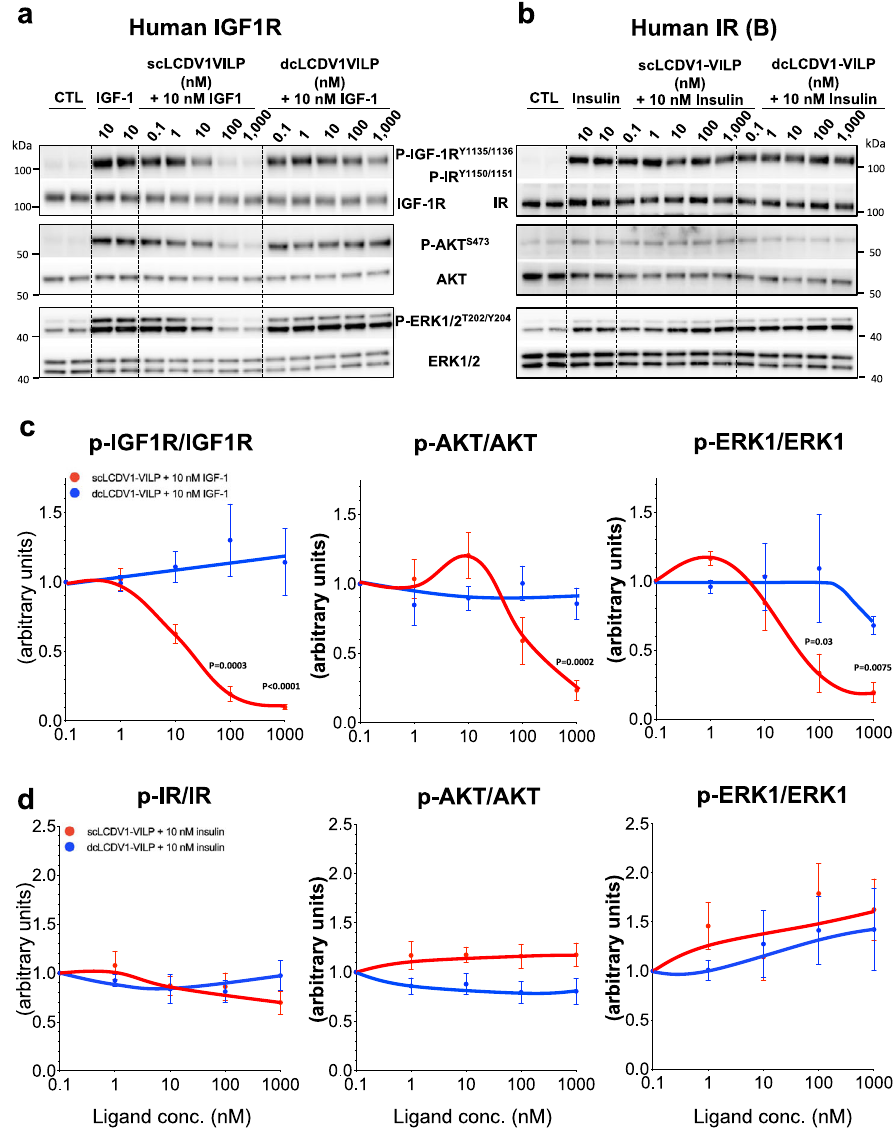
Fig. 3 | scLCDV1-VILP is a potent IGF1R antagonist. Western blot detection of IGF1R, IR, AKT, ERK1 and ERK2 phosphorylation in lysates of murine preadipocyte overexpressing the humanIGF1R ( a ) or the humanIR isoform B ( b) as describedin Methods.QuantitationofphosphorylatedIGF1R,IR,AKTandERK1.Scanintensities